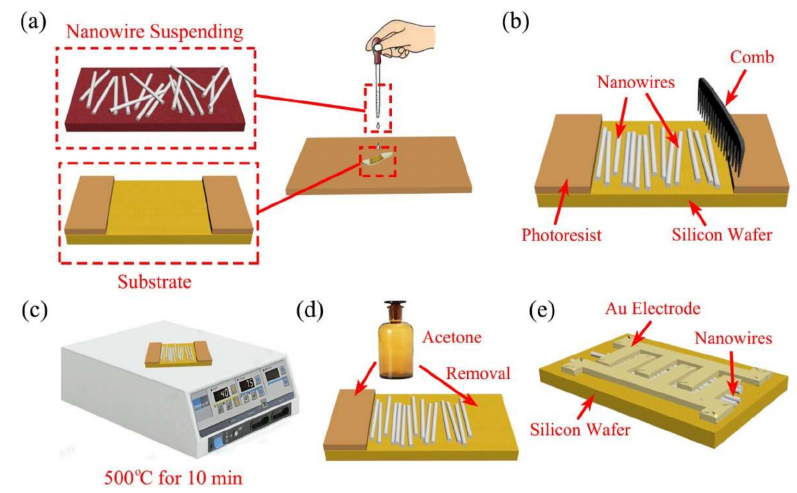
Figure 2. Simplified process flow diagram of the assembly of nanowire on the silicon substrate and nanodevice fabrication. ( a ) Drip a drop of the suspension on the substrate; ( b ) combing process after 24 h; ( c ) bake on hot plate for ~10 min at 500 ◦ C; ( d ) remove the photoresist and not adhered nanowires by acetone; ( e ) standard electron-beam lithography and metal deposition.